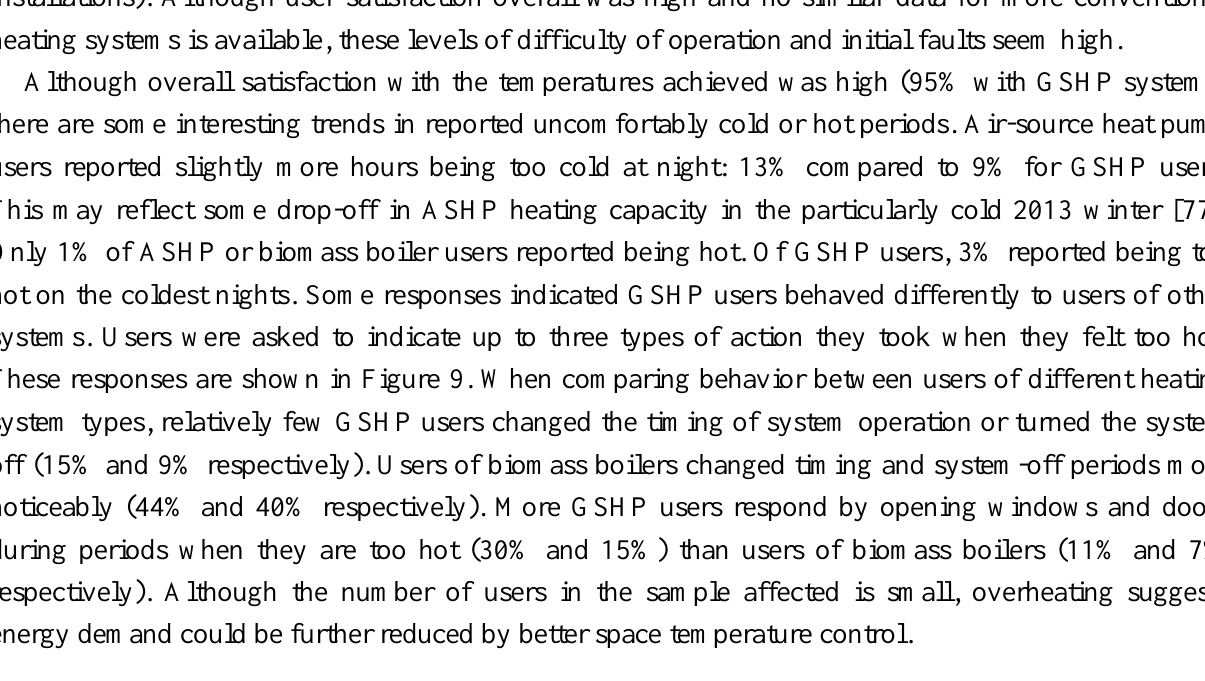
Figure 9. User responses to overheating reported from online follow-up questionnaires in the first phase of the RHPP programme [77]. Adapted from